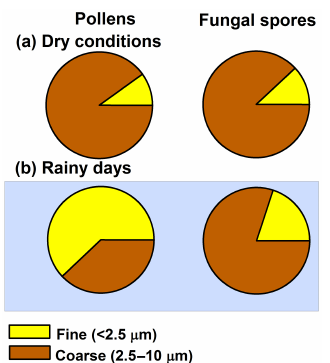
Figure 6. Distribution of pollen and fungal spore mass (apportioned by the CMB model) across fine and coarse PM during dry and rainy conditions. The fine- and coarse-mode distributions of pollens and fungal spores shifted towards fine particles during rain, with a more pronounced effect for pollens compared to fungal